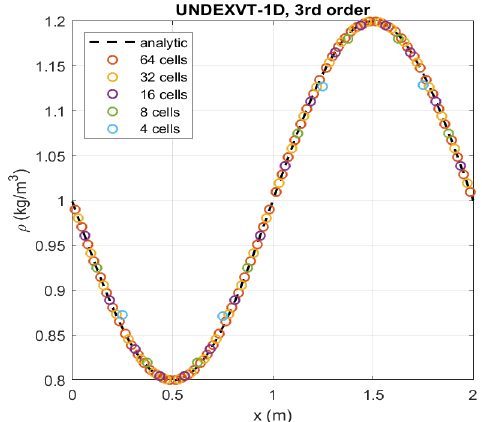
Figure 6. Simulation of cases in the table using the 1D third-order solver.